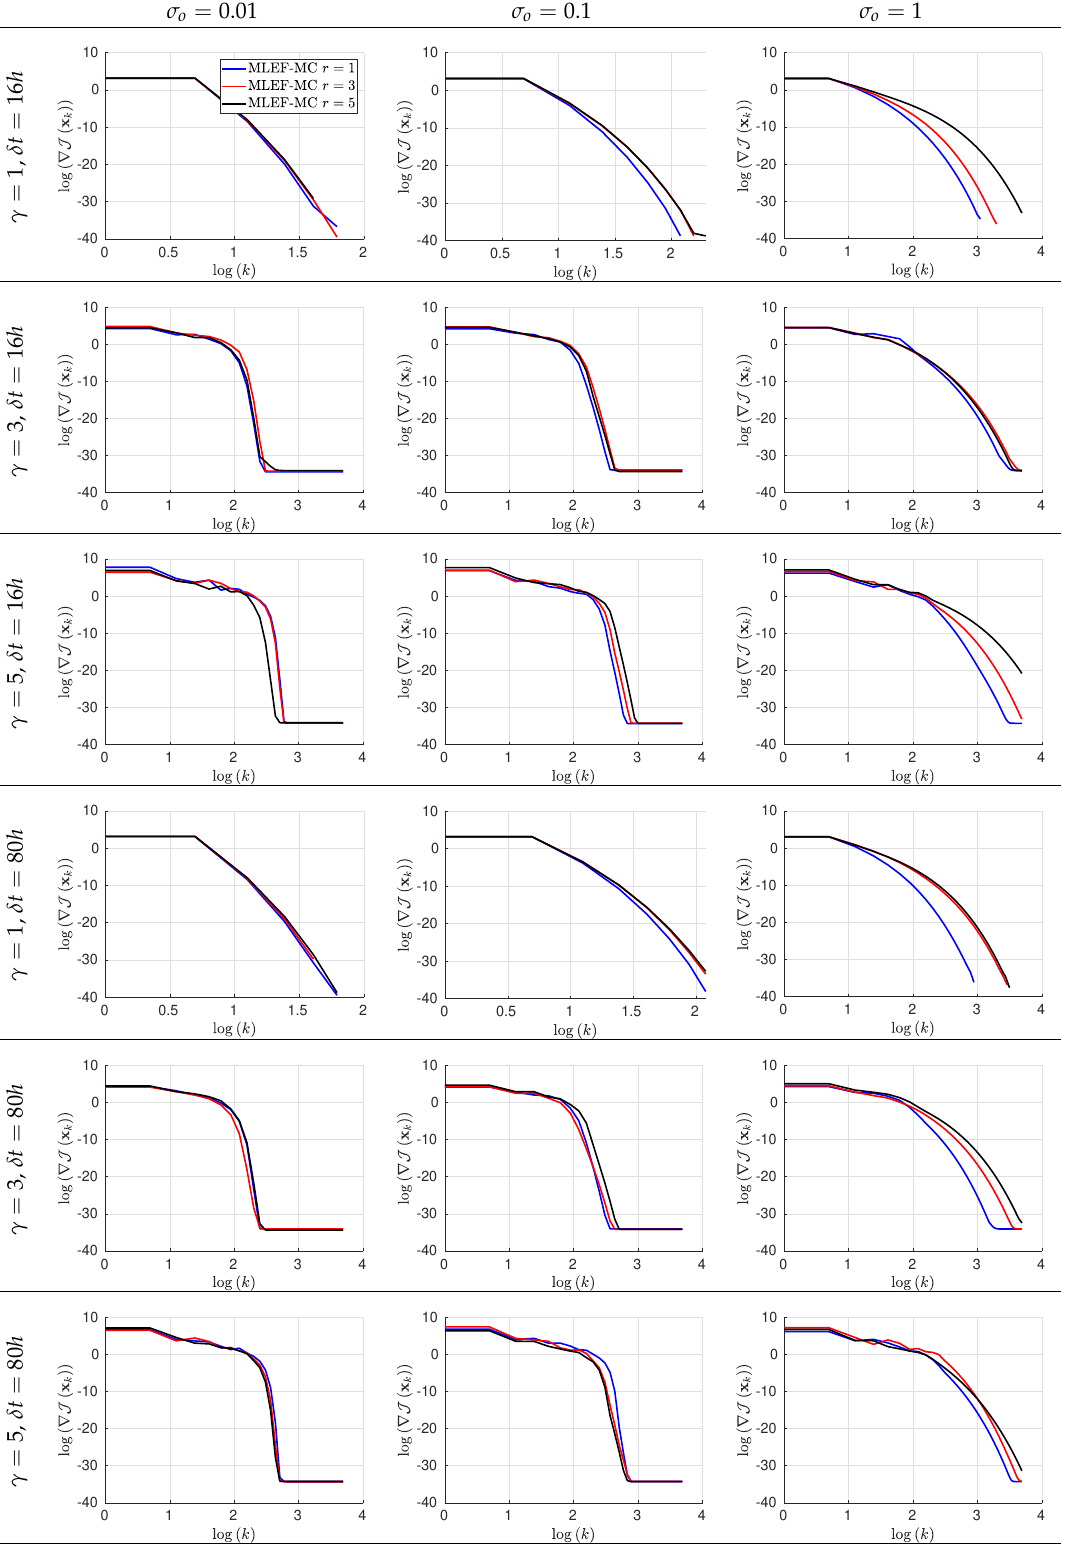
Figure 5. Gradient norms in the log-scale of the Maximum Likelihood Ensemble Filter via a Modified Cholesky decomposition (MLEF-MC) for the initial assimilation step. Different time frequencies of observations were employed during the experiments. The observation coverage from the model state reads s =